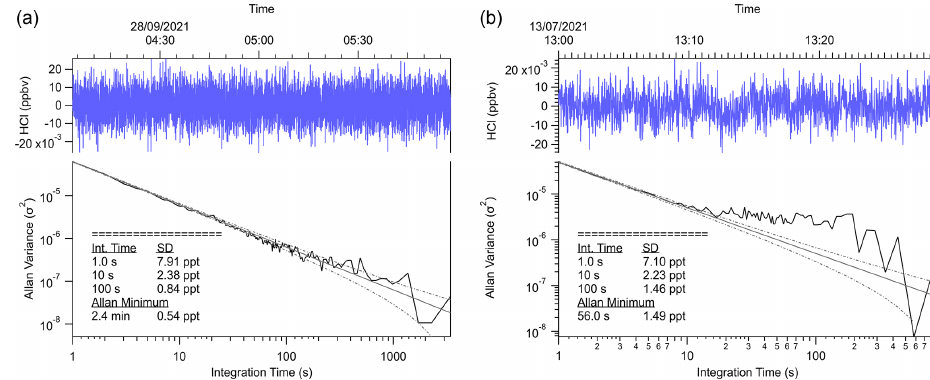
Figure 3. Allan variance plot demonstrating the signal variance and limit of detection calculations for varying integration times.